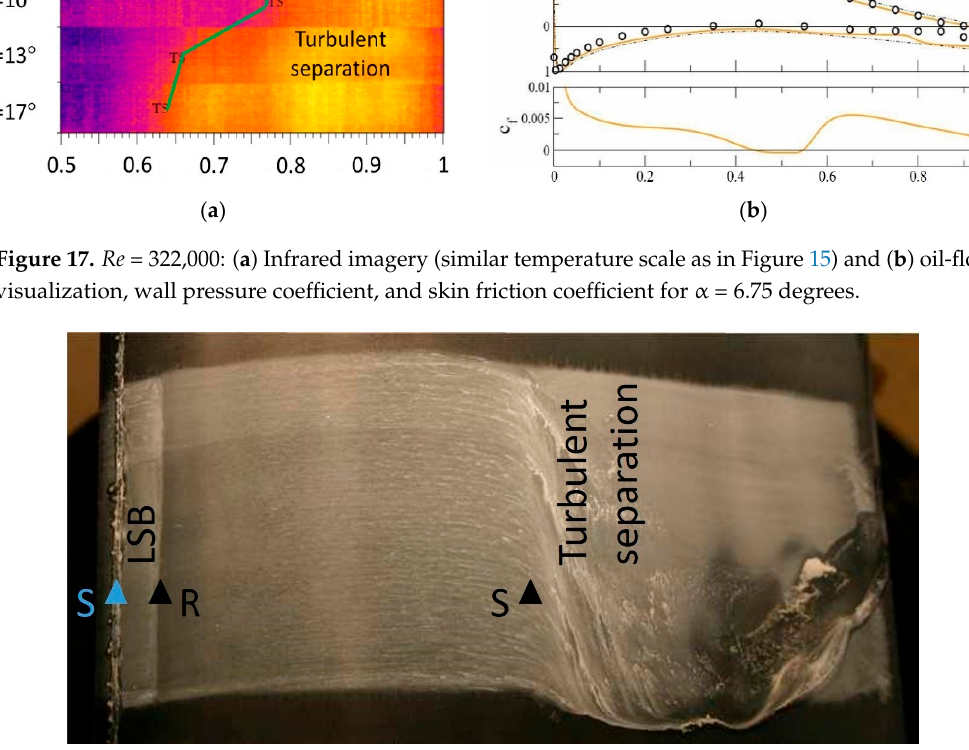
Figure 18. Oil-flow visualization for Re = 322,000 and α = 13.2 degrees.